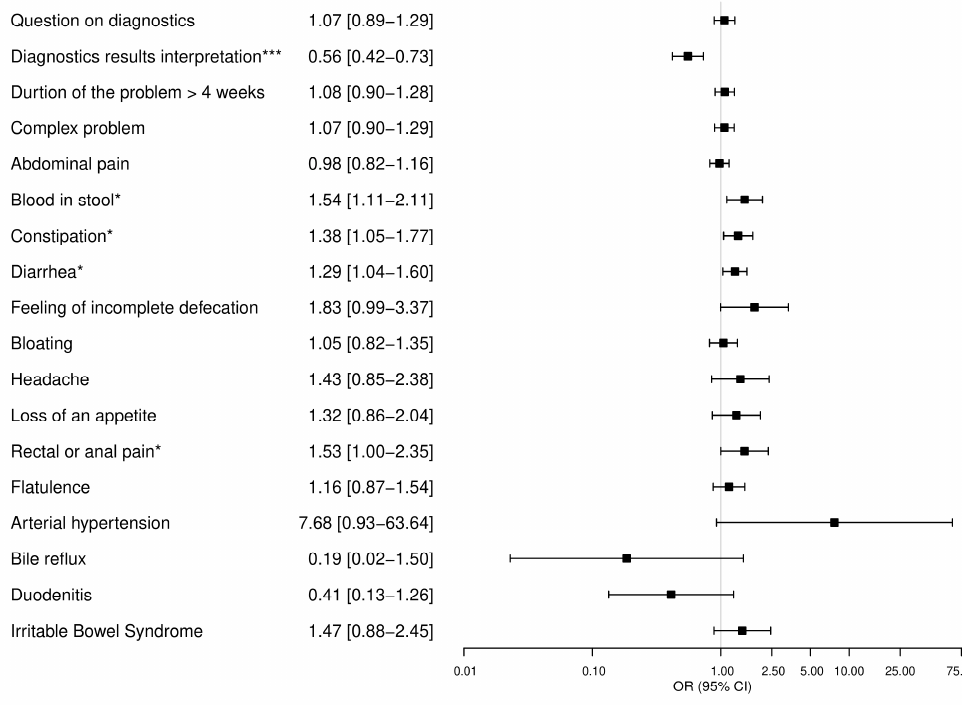
Figure 2. Multivariate logistic regression analysis. Dependent model: obtaining an answer related to the original poster’s problem (coded as one). The results are presented as odds ratio [95% confidence interval]. CI: Confidence Interval, OR: Odds Ratio, * p -value < 0.05, *** p -value <